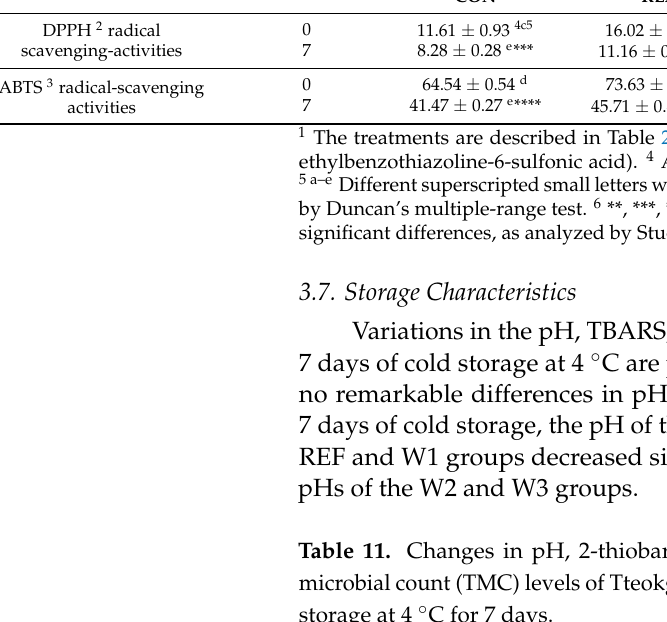
Table 11. Changes in pH, 2-thiobarbituric acid (TBA), volatile basic nitrogen (VBN), and